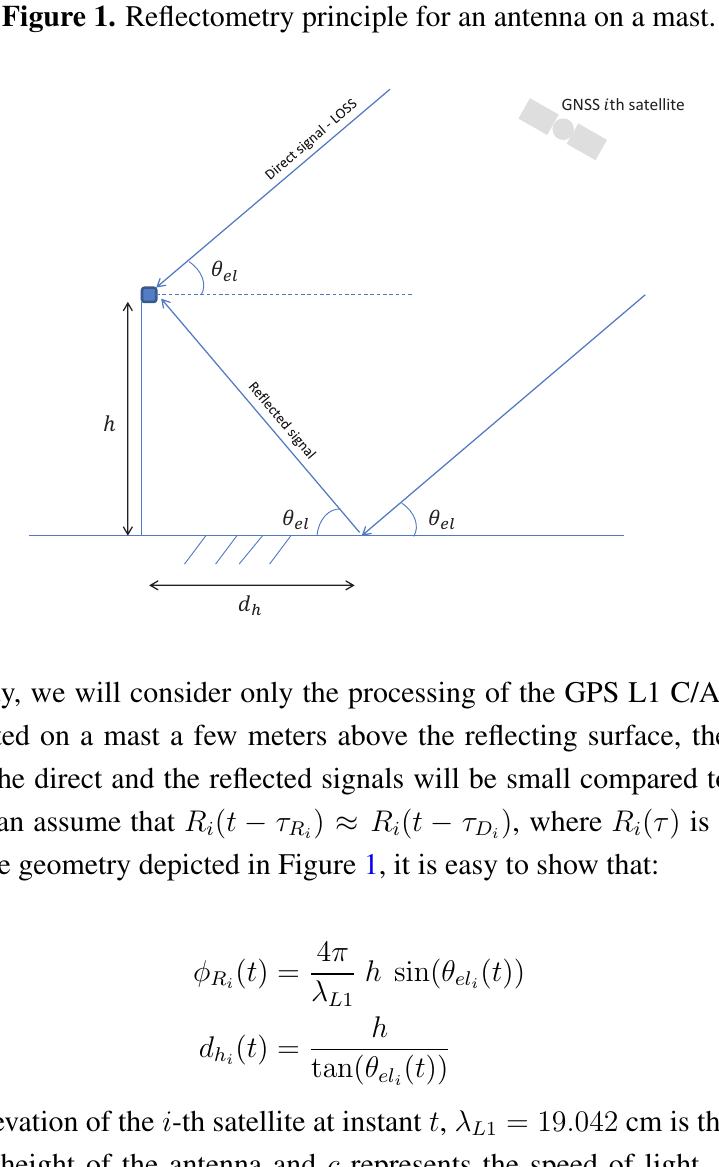
Figure 1. Reflectometry principle for an antenna on a